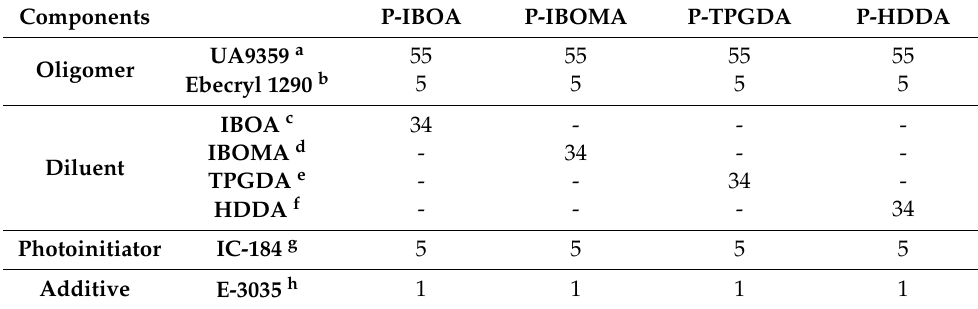
Table 2. Formulations of the UV-curable